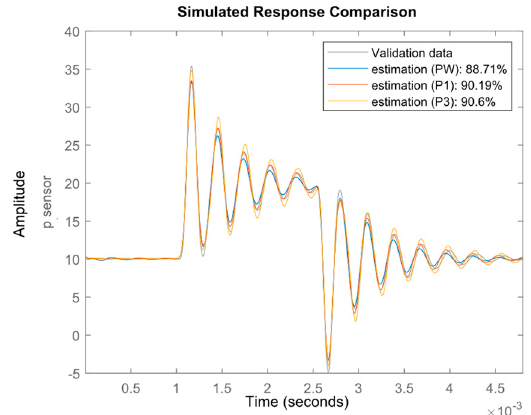
Figure 9. Comparison of CFD ‐ simulated responses with estimates for different reference points.